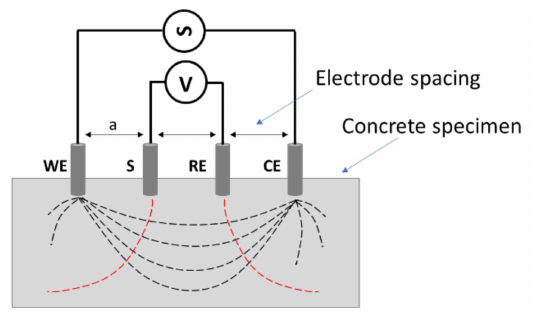
Figure 2. Wenner array